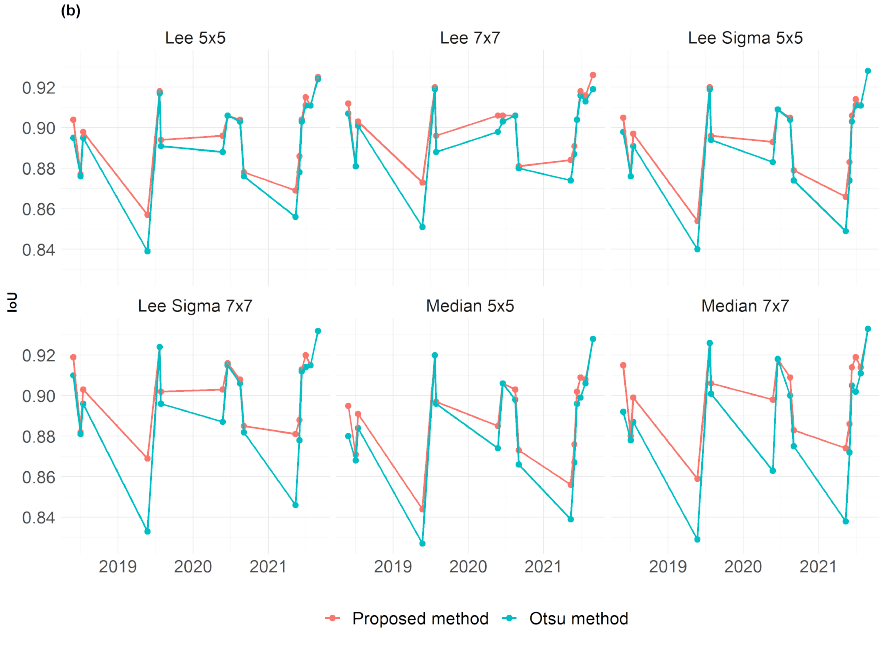
Figure 10. IoU -similarity over time for the proposed method and the Otsu method with different speckle filtering parameters.